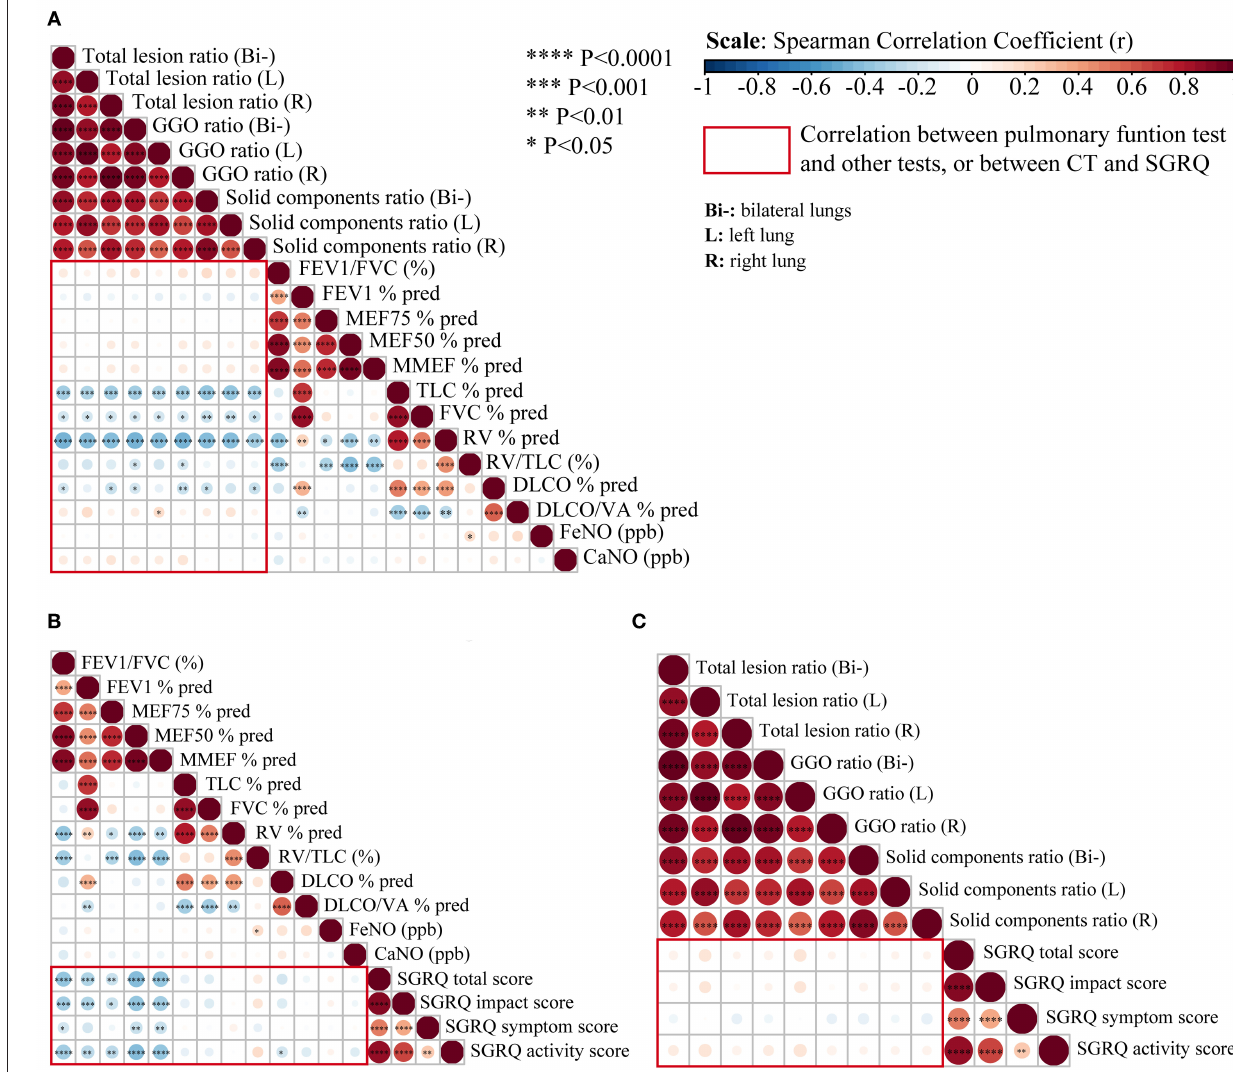
FIGURE 3 | Correlation analysis between pulmonary function, chest CT, and SGRQ in recovered severe/critical and mild/moderate COVID-19 patients. (A) Correlation matrices of chest CT abnormalities and pulmonary function test at 3-month follow-up. (B) Correlation matrices of pulmonary function test and St. George’s Respiratory Questionnaire (SGRQ) scores at 3-month follow-up. (C) Correlation matrices of chest CT abnormalities and SGRQ scores at 3-months follow-up, (Bi-) refers to bilateral lungs; (L) refers to left lung; (R) refers to right lung. Spearman’s correlation coefficient ( r ) of each comparison group can be visualized from color intensity (blue color represents negative correlation, red color represents positive correlation) and dot size. The correlation analysis among the above three comparison group is highlighted within the red rectangular boxes. Statistically significant correlation with P < 0.05 have been marked as **** P < 0.0001; *** P < 0.001; ** P < 0.01, * P < 0.05.